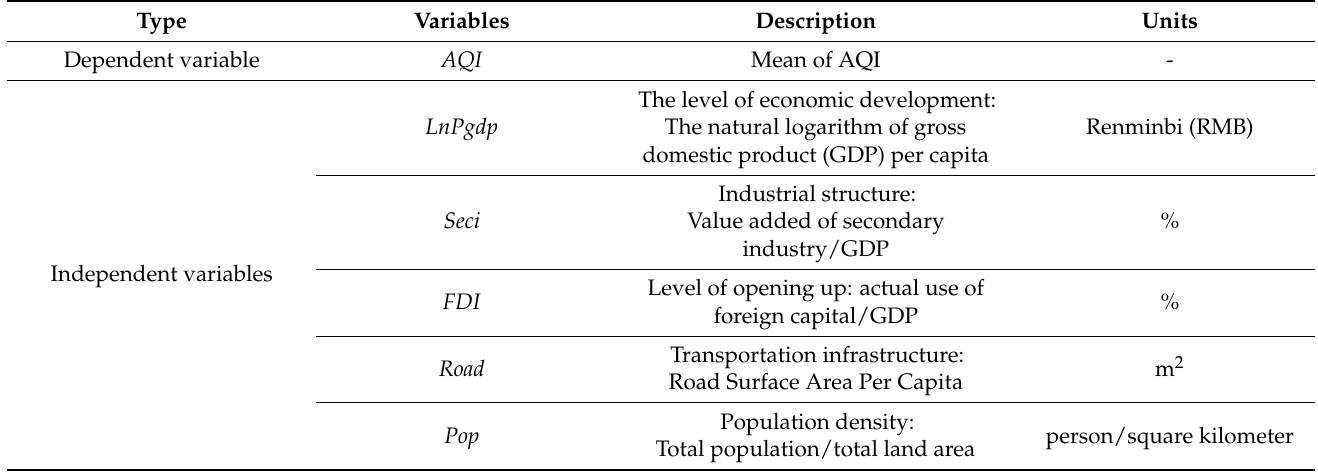
Table 2. Definitions of